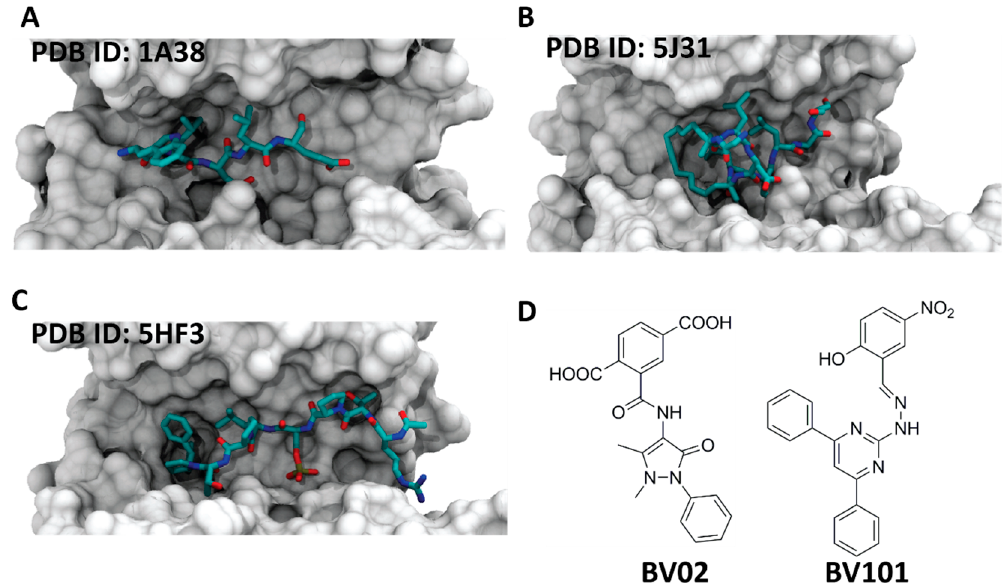
Figure 7. Examples of the different classes of 14-3-3 PPI inhibitors. ( A ) Crystal structure of peptide R18 (cyan sticks) in the 14-3-3 ζ binding groove (white surface) (PDB ID: 1A38) [55]; ( B ) crystal structure of ExoS-derived alkyne cross-linked cyclic peptide (cyan sticks) in the 14-3-3 ζ binding groove (white surface) (PDB ID: 5J31) [57]; ( C ) crystal structure of modified Tau peptide hybrid 3b (cyan sticks) in the 14-3-3 σ binding groove (white surface) (PDB ID: 5HF3) [58]; ( D ) chemical structures of BV02 and BV101.